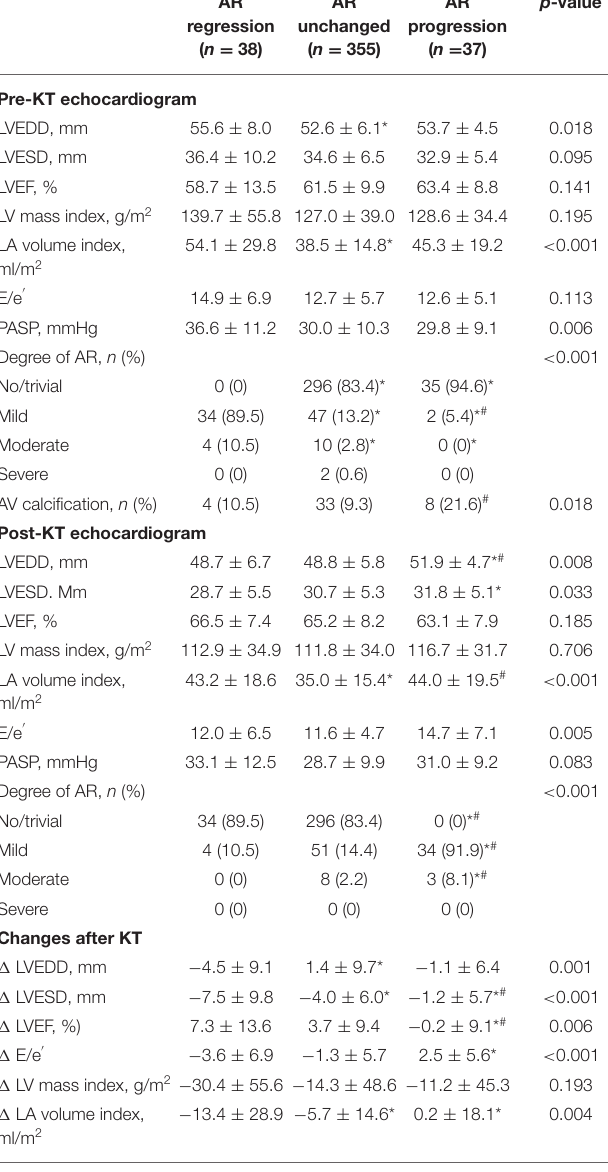
TABLE 5 | Comparison of echocardiographic characteristics in the three groups according to change in aortic regurgitation. AR regression